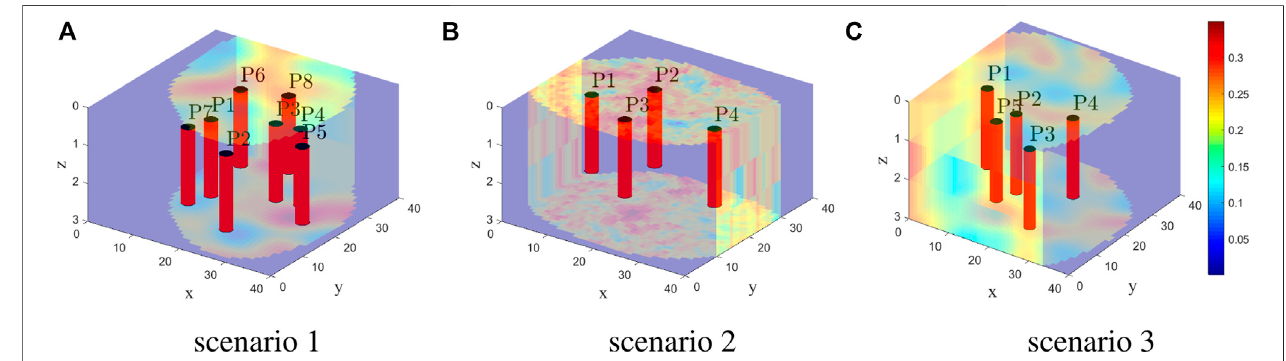
FIGURE 12 | Well con fi guration proposed by the best arti fi cial intelligence agent for three random 3D fi eld development scenarios.